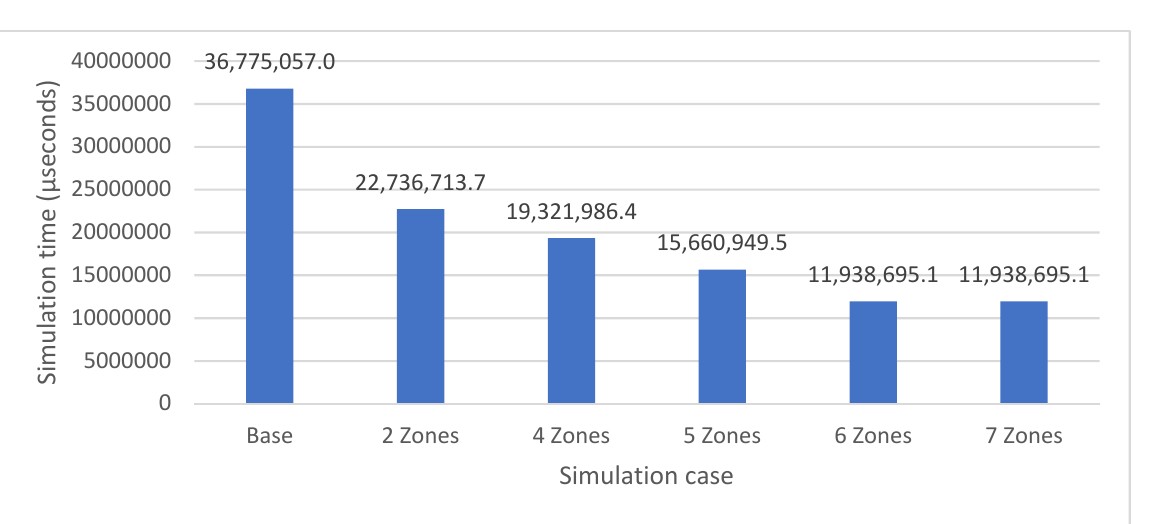
Figure 6. Simulation time reduction as a percentage of the reference. Figure 7. Partition statistics considering five different number of zones for Circuit 5. 4. Conclusions Spatial parallelization has proven to be a technique for accelerating power system simulations by reducing the circuit model’s complexity. The circuit model’s complexity is reduced by tearing the model into several subnetworks that can be solved faster than the